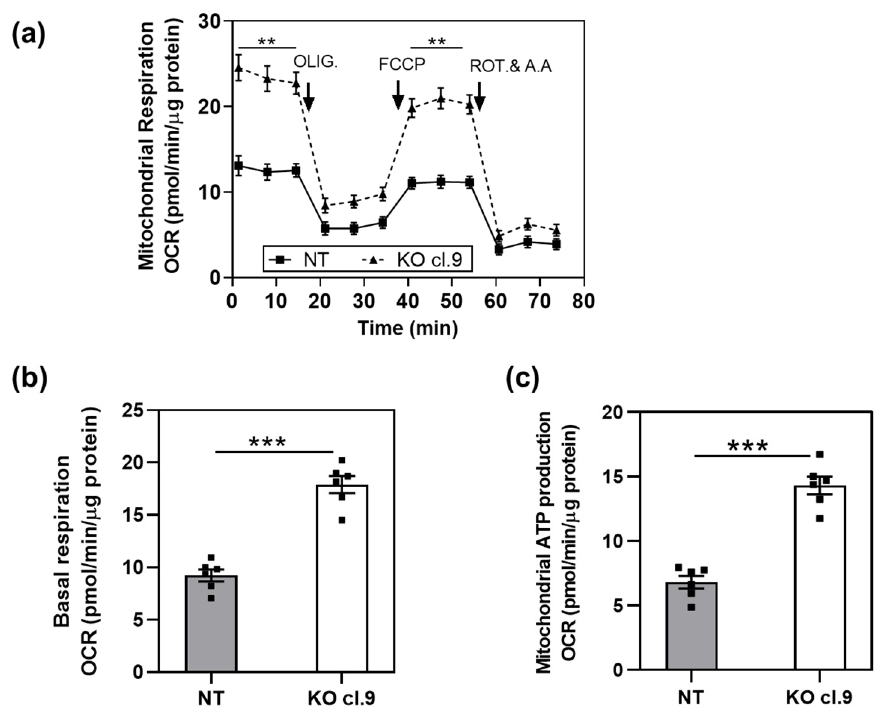
Figure 2. Depletion of ARRB1 alters mitochondrial respiration: ( a ) oxygen consumption rate (OCR) of ARRB1-depleted HT1376 cells (KO cl.9) and corresponding controls (NT) prior to and after injection of respiration modulators oligomycin (OLIG.), FCCP, and rotenone/antimycin A (ROT and A.A). Data: means ± SEM, n = 6; ** p < 0.01 (Two-way RM ANOVA). ( b ) Basal respiration in ARRB1-depleted HT1376 cells (KO cl. 9) and corresponding controls (NT). Data: means ± SEM, n = 6; *** p < 0.001 (two-tailed unpaired t test). ( c ) Mitochondrial ATP production in ARRB1-depleted HT1376 cells (KO cl. 9) and corresponding controls (NT) (calculated using the Seahorse XF Cell Mito Stress Test Generator). Data: means ± SEM, n = 6; *** p < 0.001 (two-tailed unpaired t test).